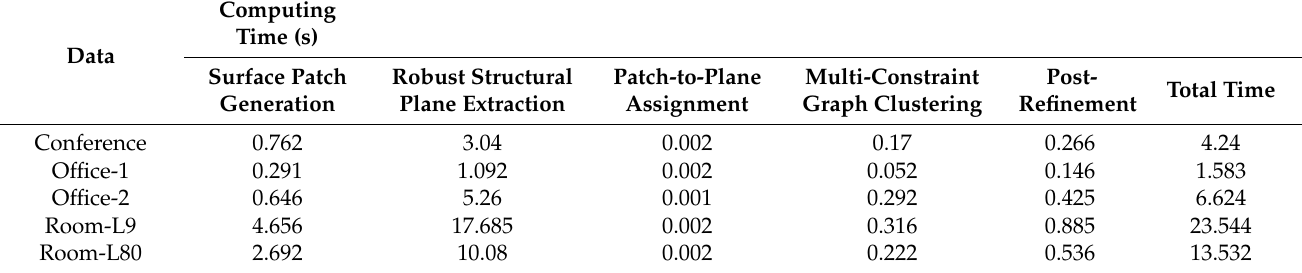
Table 4. Execution time of experimental